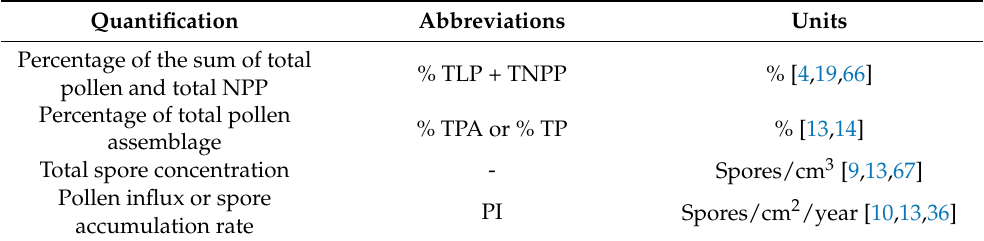
Table 1. Quantification method, abbreviations used, units, and references for each